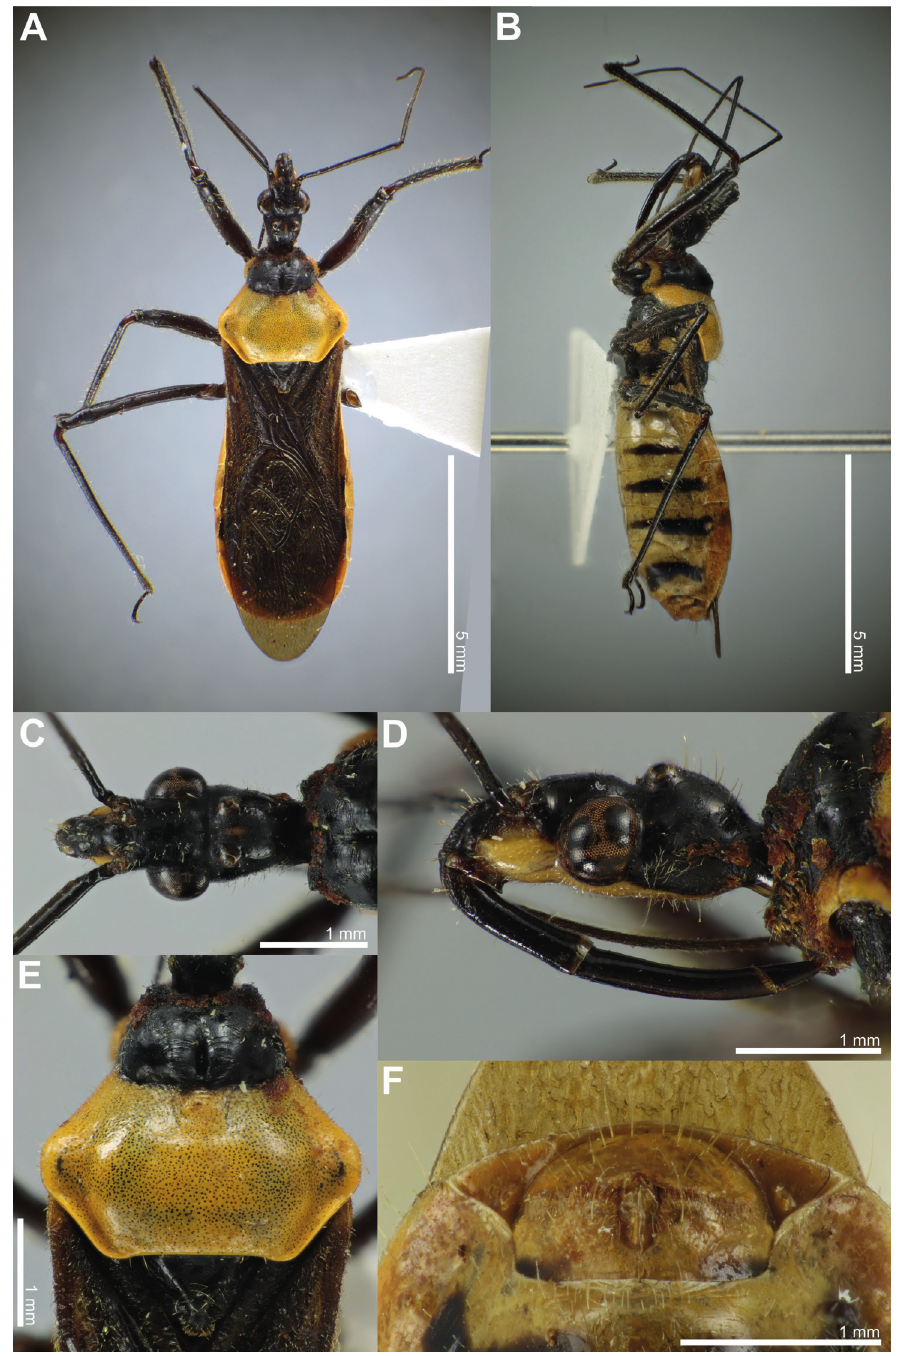
Figure 7. Biasticus flavinotus (Matsumura, 1913), ♀ , TW-Redu-2014-001 A body in dorsal view B body in lateral view C head in dorsal view D head in lateral view E pronotum in dorsal view F female external genitalia in ventral